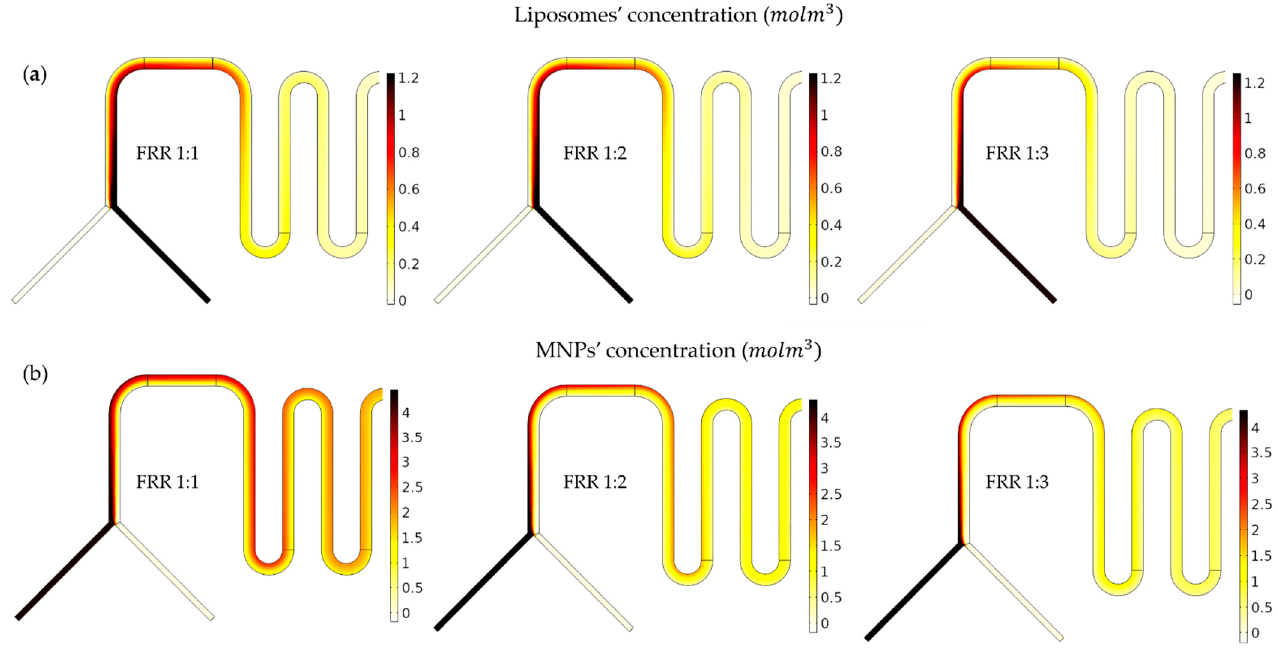
Figure 7. Comparison of the diluted species model results. ( a ) Liposome concentration profile; ( b ) MNP concentration profile. Results for different FRRs along the first section of the microfluidic device are shown.